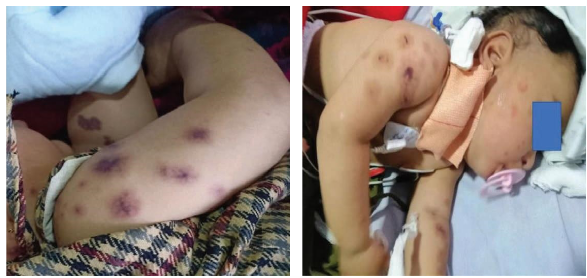
Figure 1: Purpuric rash over the upper limbs and face of an 11 months old Table 1: Laboratory fndings.